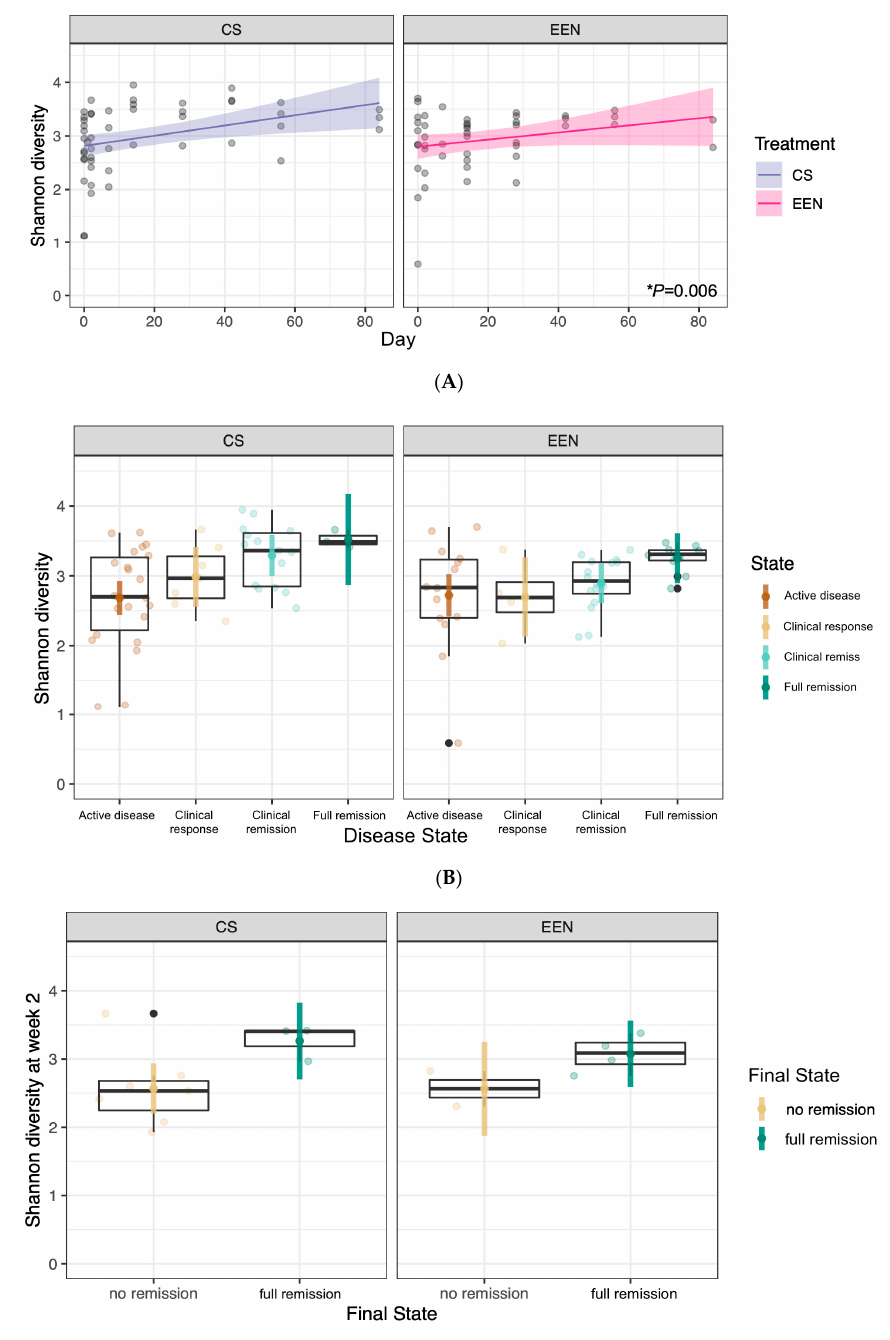
Figure 6. ( A ) Shannon diversity over time separated by treatment. A significant increase in Shannon diversity was observed over time (day 0 to day 84), independent of the treatment received ( p = 0.006). ( B ) Shannon diversity over the disease state separated by treatment. A significant increase in Shannon diversity was observed over the disease state (active disease, clinical response, clinical remission, full remission) in both CS- and EEN-treated patients ( p = 0.007). ( C ) Shannon diversity at week 2 compared to the final remission status at the end of treatment, separated by treatment type. A significant difference in Shannon diversity at week 2 was observed between patients who achieved remission at the end of treatment and those who did not achieve remission ( p = 0.044). CS—corticosteroids, EEN— exclusive enteral nutrition.